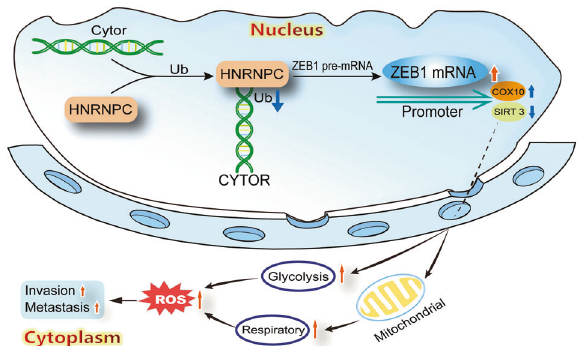
Fig. 8 Schematic diagram of CYTOR-HNRNPC-ZEB1 axis regulates the energy metabolism-mediated metastasis of oral cancer cells. LncRNA CYTOR enhances ZEB1 expression via HNRNPC-mediated mRNA stabilization to alter energy metabolism, ultimately facilitat- ing metastasis and invasion of oral cancer